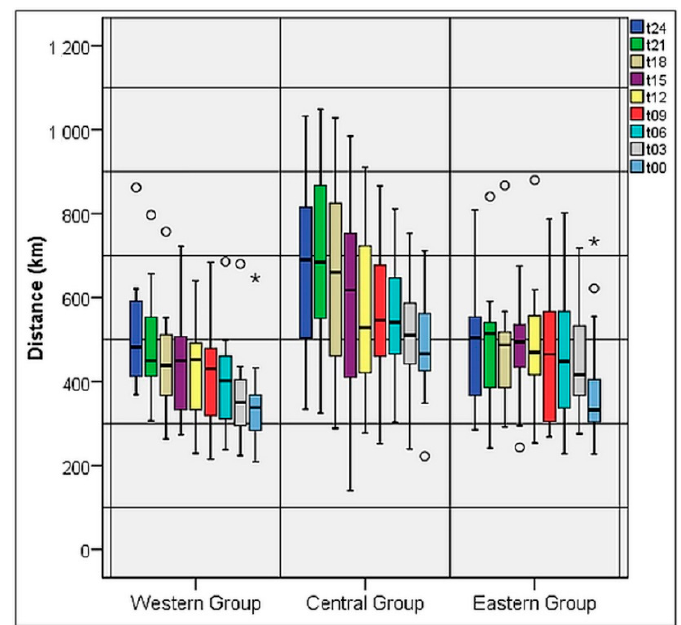
Figure 10. The boxplots for the averaged shortest distance between the storm center and TPW contour line of 40 mm by regional groups during 24 h prior to landfall. Circles (stars) denote values at least 1.5 (3) times the interquartile range.